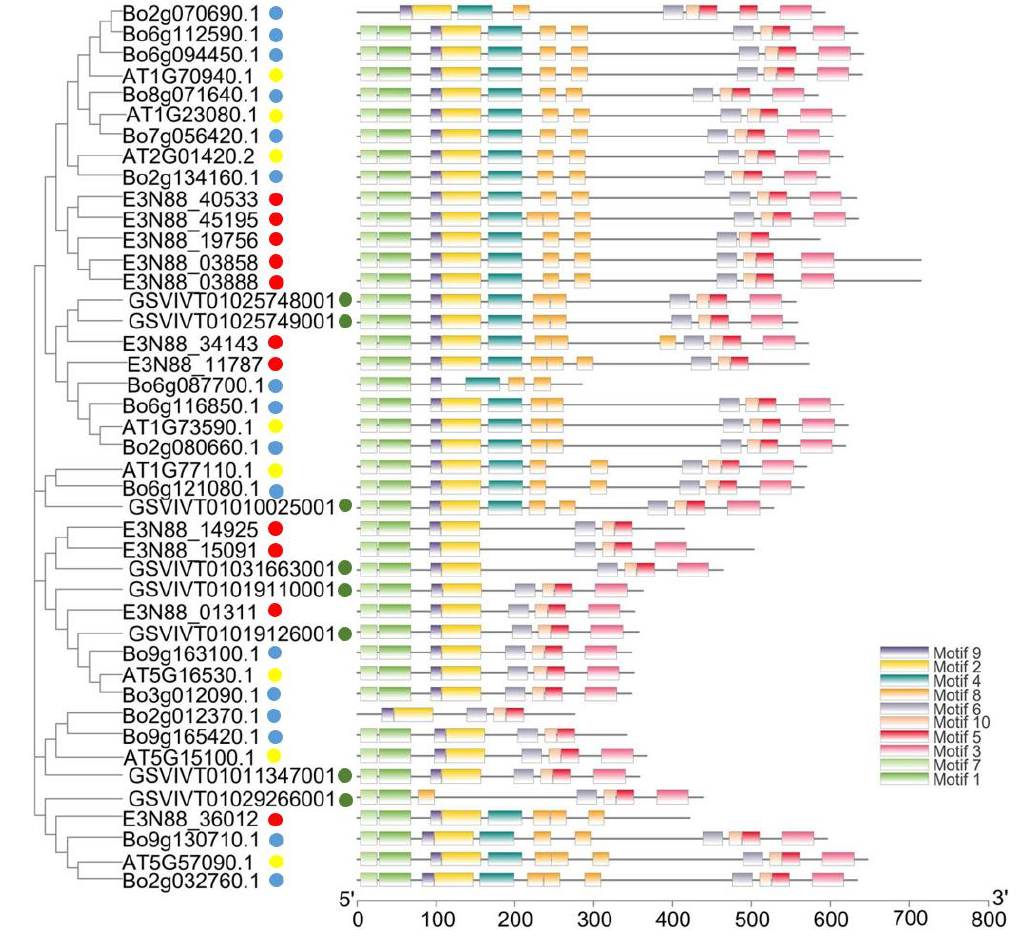
Figure 5. Conserved motifs analysis of PINs in M. micrantha , A. thaliana , B. oleracea and V. vinifera . Ten predicted motifs are shown by different colored boxes, and motif sizes are demonstrated by the scale on the right. M. micrantha , A. thaliana , B. oleracea and V. vinifera are distinguished by solid circle shapes in red, yellow, blue and green, respectively.